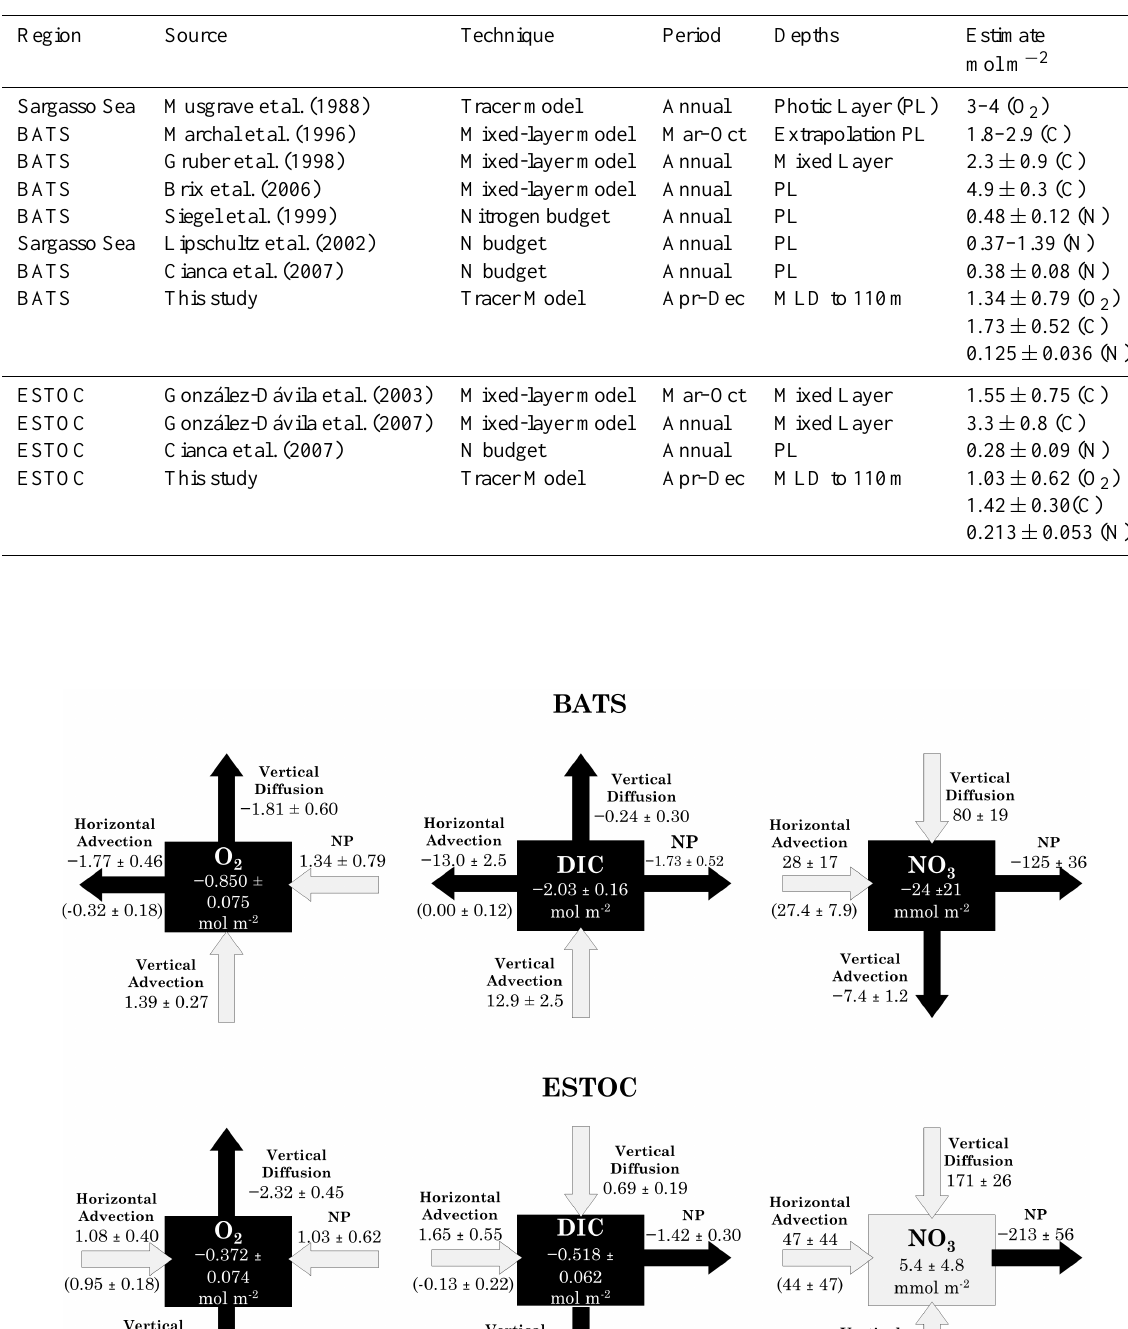
Table 1. Summary of net production estimates reported for BATS and ESTOC. MLD is the mixed-layer depth.